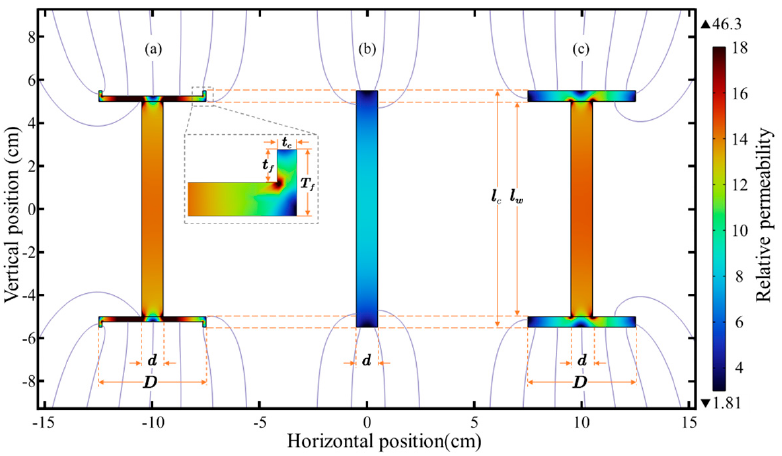
Figure 4. µ app in different flux concentrators: ( a ) magnetic core with rod core and cupped flux concentrator, ( b ) magnetic core only with rod core, and ( c ) magnetic core with rod core and flux concentrator.